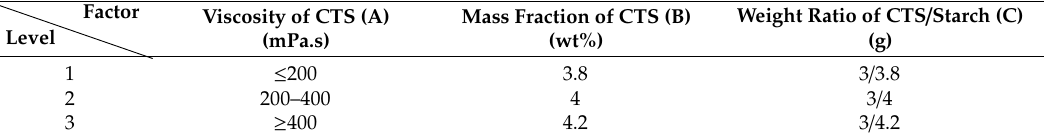
Table 1. Formula of CTS-starch